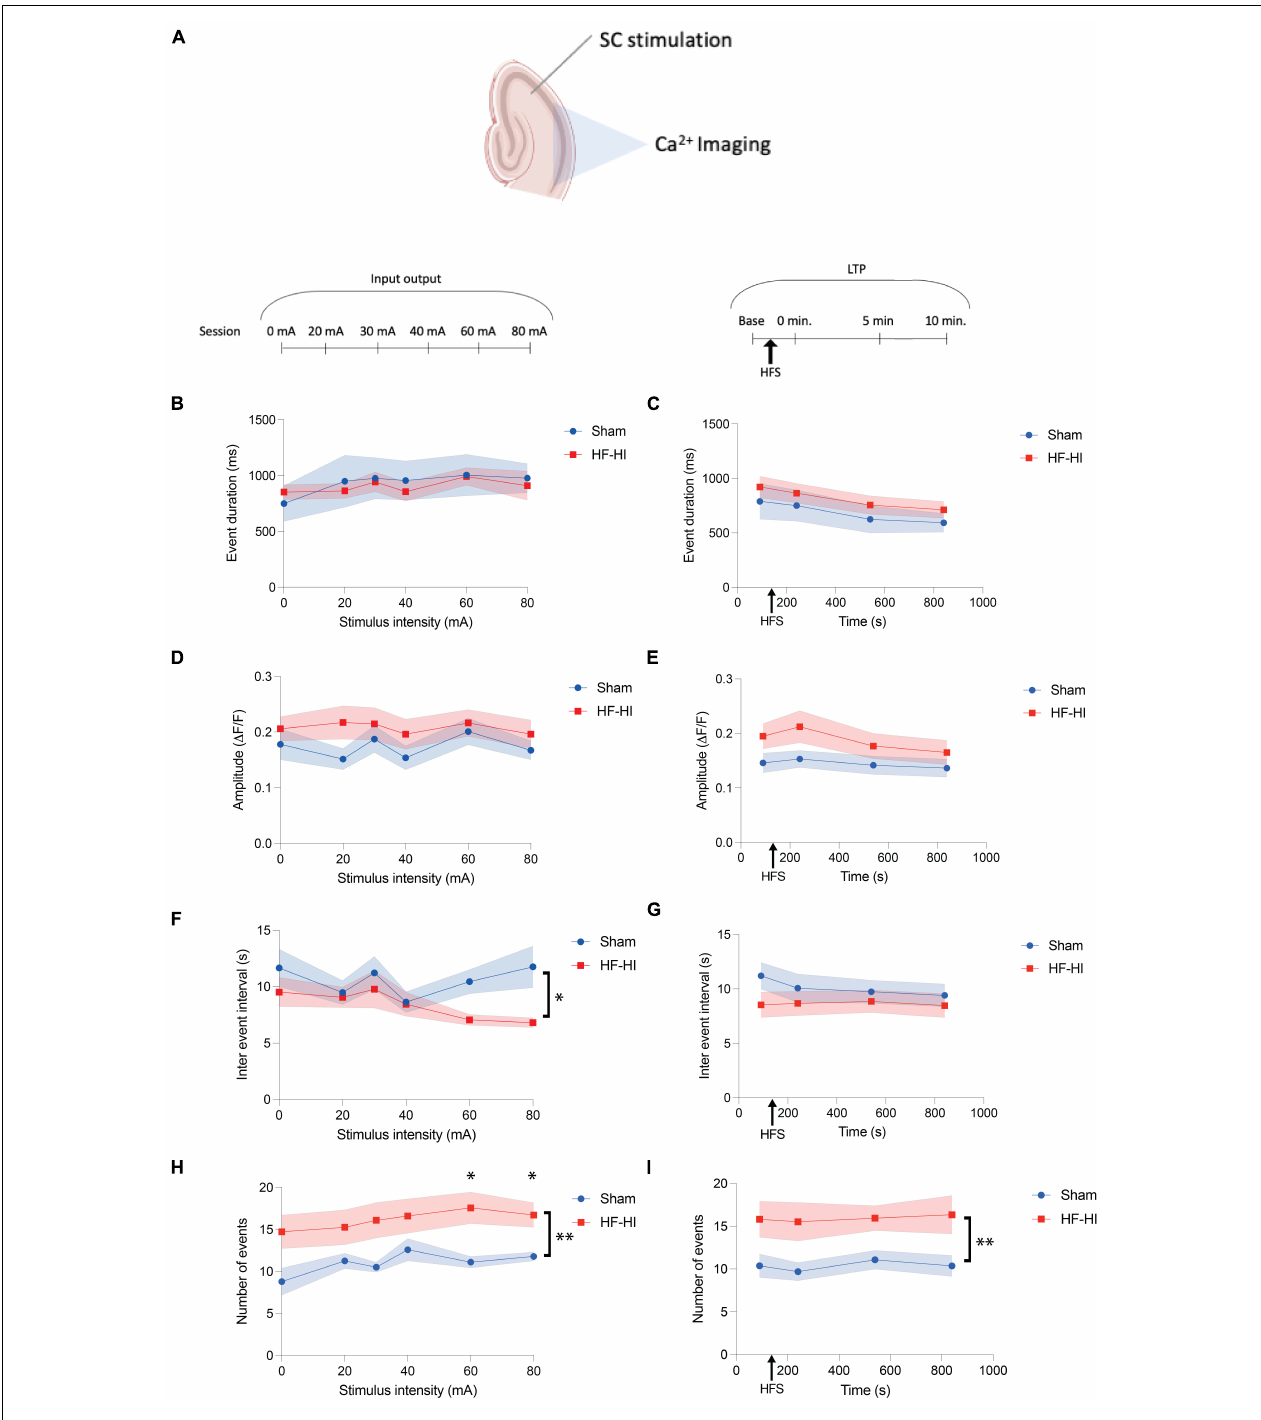
FIGURE 3 | High Frequency Head Impact (HFHI) increases the number of calcium transients but does not alter event features. (A) Acute slices from Thy1-GcAMP6f mice were prepared 24 h following the last day of HFHI and calcium imaging of the CA1 field was performed during an abbreviated LTP paradigm. (B) HFHI does not alter calcium transient duration during the input output curve or (C) following HFS of the Schaffer collaterals. A similar trend was seen for normalized event amplitude in the (D) input output sessions and (E) LTP sessions. (F) HFHI slices displayed a significant decrease in the IEI during the input output sessions, but not (G) the LTP sessions. The average number of calcium transients was significantly increased in HFHI slices during (H) the input output sessions and (I) the LTP sessions. Shaded regions represent mean ± SEM. With brackets: mixed effects analysis, * p < 0.05, ** p < 0.01, (F) n Sham = 13, n HFHI = 13, (H) and (I) n Sham = 12, n HFHI = 13 (one sham outlier removed). Above graph in (I) Šídák’s multiple comparisons test, * p < 0.05, n Sham = 12, n HFHI = 13.